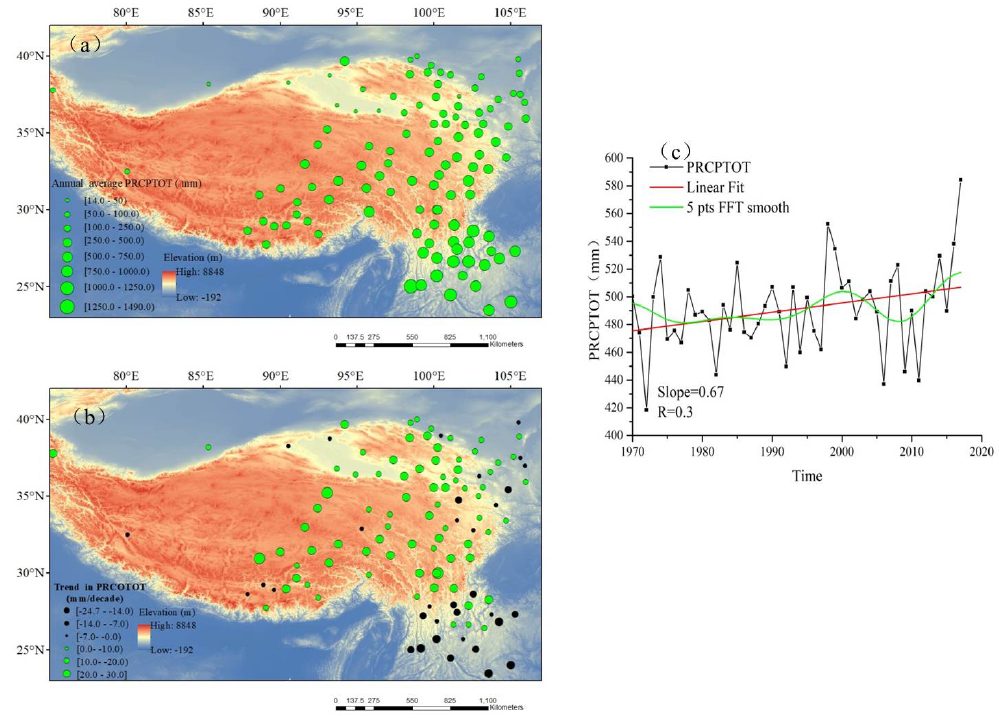
Figure 2. Spatial distribution of the averaged and long-term climatological trends in annual mean PRCPTOT ( a,b ) and changes in annual mean PRCPTOT ( c ) in the TP and TPS during 1971–2017.